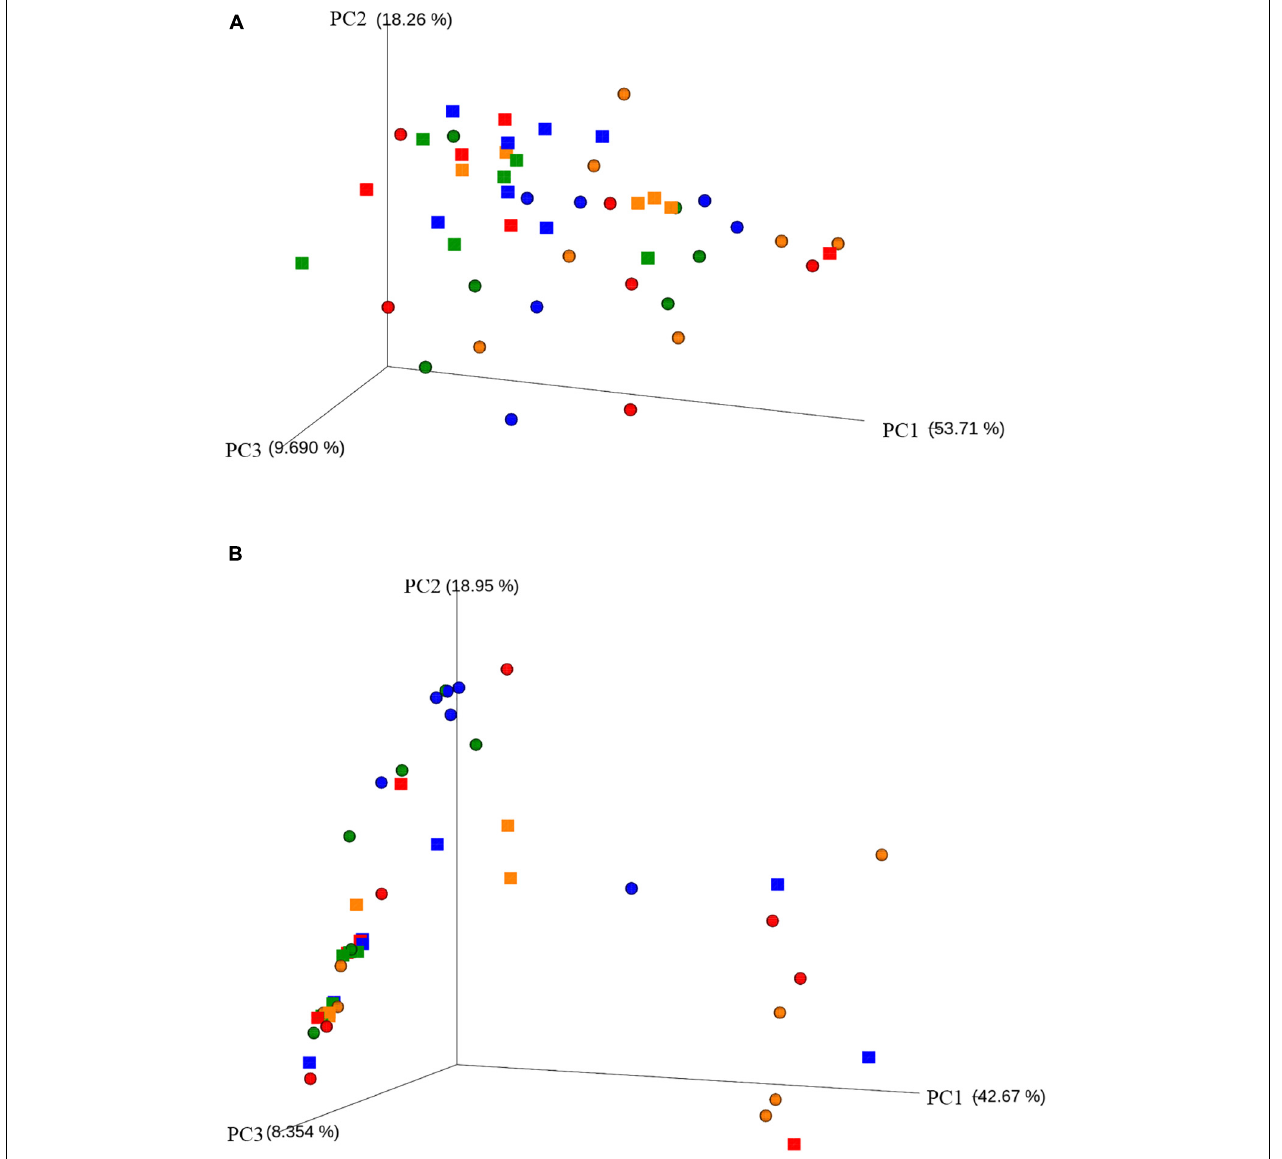
FIGURE 2 | Principal coordinate analysis (PCoA) based on weighted (A) and unweighted (B) UniFrac distances of bacterial OTUs. (A) The first, second, and third axes explained 81.66% of the total variance. (B) The first, second, and third axes explained 69.97% of the total variance. Different symbols represent the different sampling sources: rings for cNAW and squares for NWS samples. Different colors represent the different sampling months: February = red, May = blue, August = orange and November =